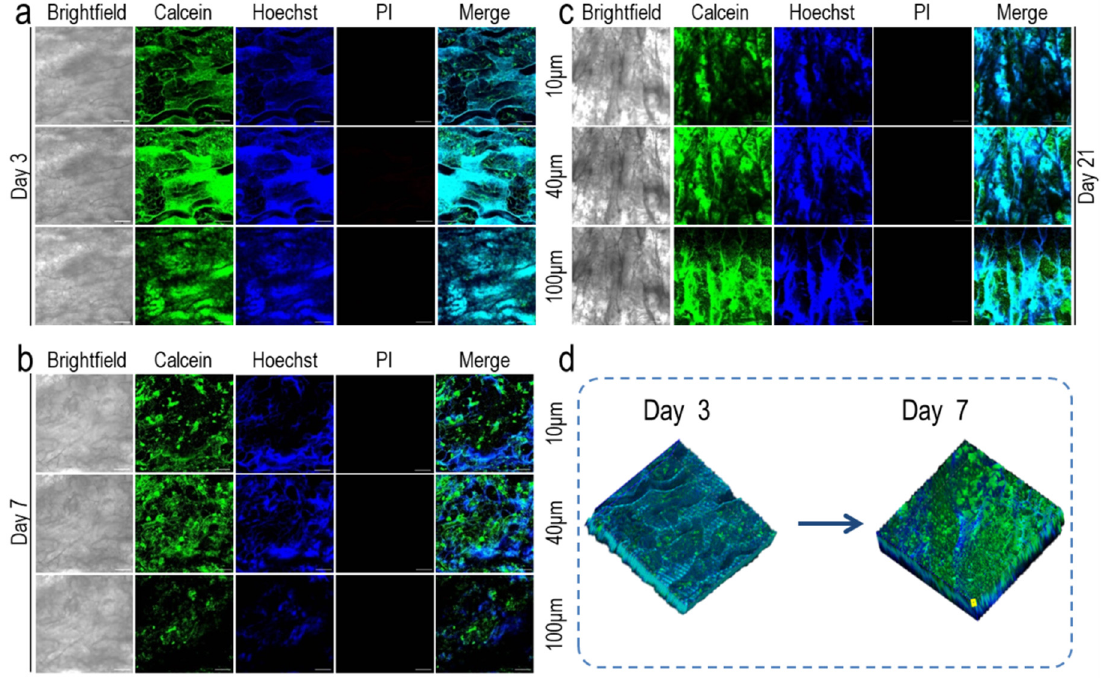
Figure 6. Infiltration of MCF-7 cells (10 μ m, 40 μ m, 100 μ m) in pig renal matrix scaffolds by laser confocal microscopy. The cells were dyed alive with calcein-Am, PI, and Hoechst 33,342, respectively. ( a ) Infiltration of MCF-7 cells on pig renal matrix scaffolds after 3 days of growth; scale: 200